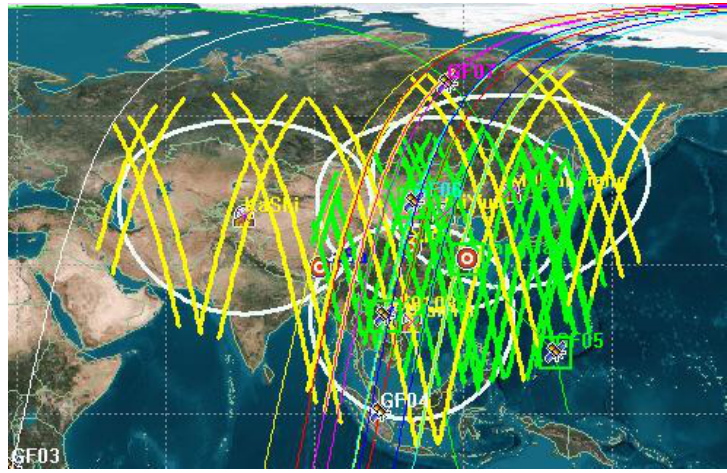
Figure 5. 3D diagram of the GF-resource satellite joint access to a moving target.